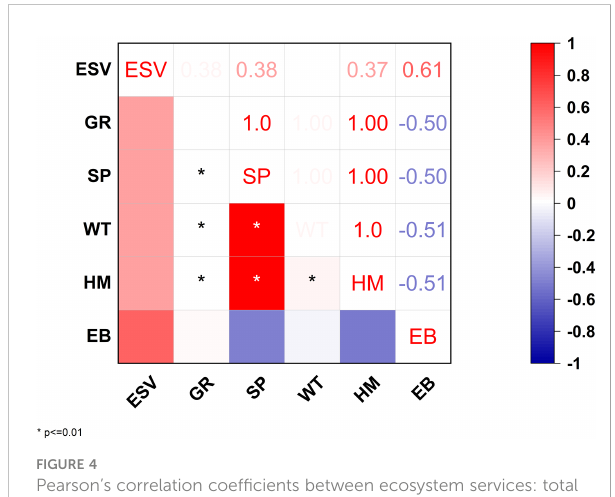
FIGURE 4 Pearson ’ s correlation coef fi cients between ecosystem services: total ESV ecosystem services value; GR, gas regulation; SP, storm protection; WT, waste treatment; HM, habitat maintenance; and EB, economic bene fi